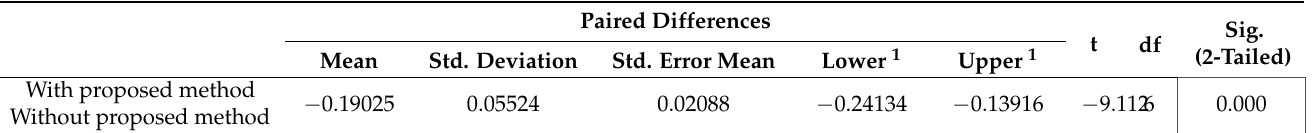
Table 16. Results of the paired-sample t -test for average interaction latency for each subject: paired differences. Paired Differences